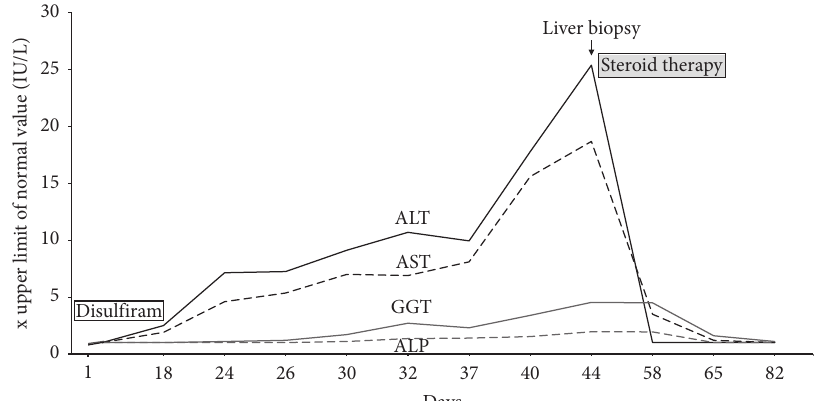
Figure 1: Graphical illustration of the course of disulfiram-induced acute hepatitis. Biological tests (AST: aspartate aminotransferase; ALT: alanine aminotransferase; GGT: gamma-glutamyl transferase; ALP: alkaline phosphatase) given as upper limit of normal value.